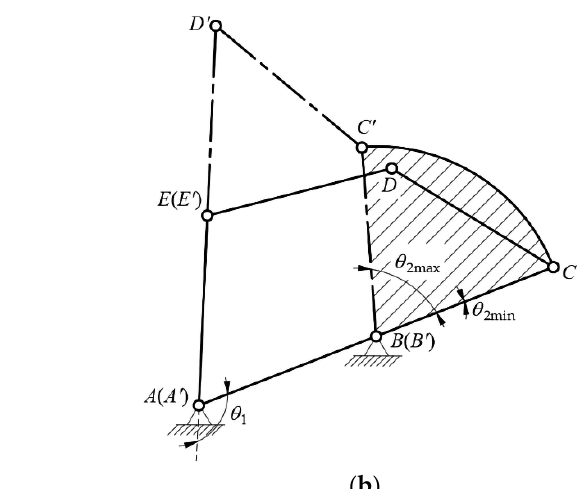
Figure 3. Active joint angle analysis of rolling angle 0 (cid:3409) 𝜙 (cid:3409) 𝜋 /5 . (a) 𝜃 (cid:2869) ∈ (cid:4670) 2 𝜋 /5 (cid:3398) 2 𝜙 , 𝜋 (cid:3398) arccos (cid:4666) 1/4 (cid:4667)(cid:4667) . (b) 𝜃 (cid:2869) ∈ (cid:4670)𝜋 (cid:3398) arccos (cid:4666) 1/4 (cid:4667) , 𝜋 (cid:3398) 2arcsin (cid:4666) 1/4 (cid:4667)(cid:4671) . (2) 𝜋 /5 (cid:3407) 𝜙 (cid:3409) 2 𝜋 /5 .